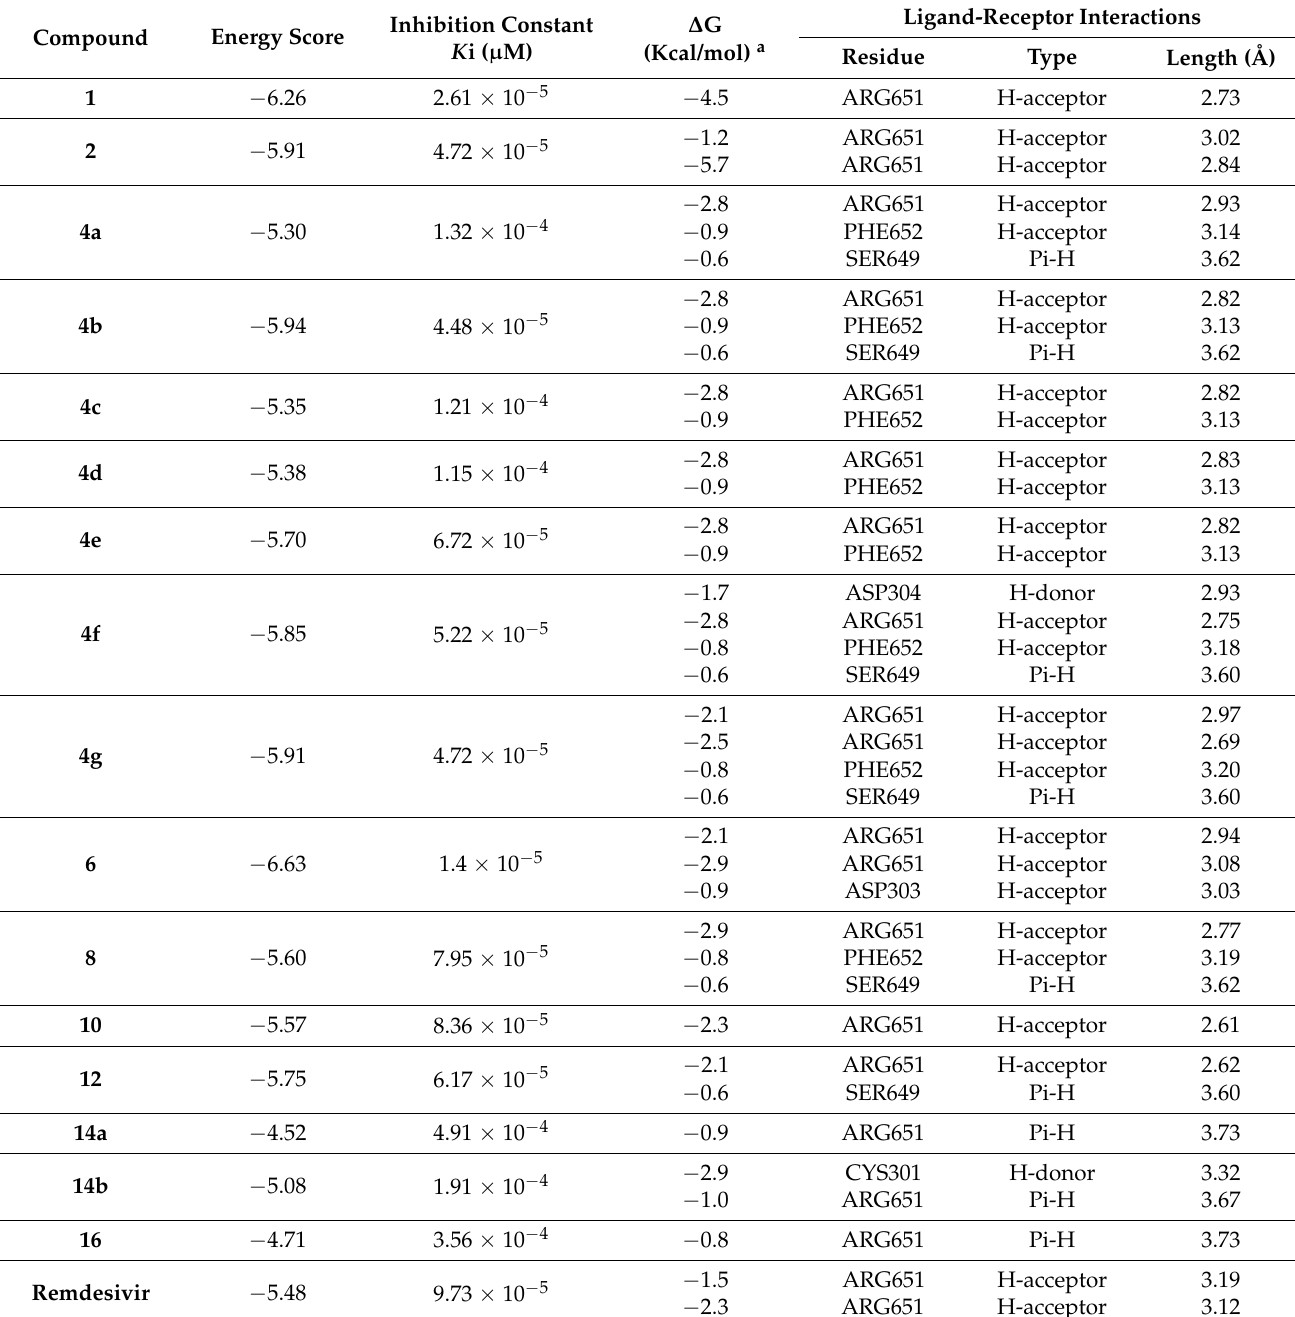
Table 1. Energy scores and types of interactions observed for the investigated compounds and the reference Remedisvir in the active sites of RdRp (PDB: